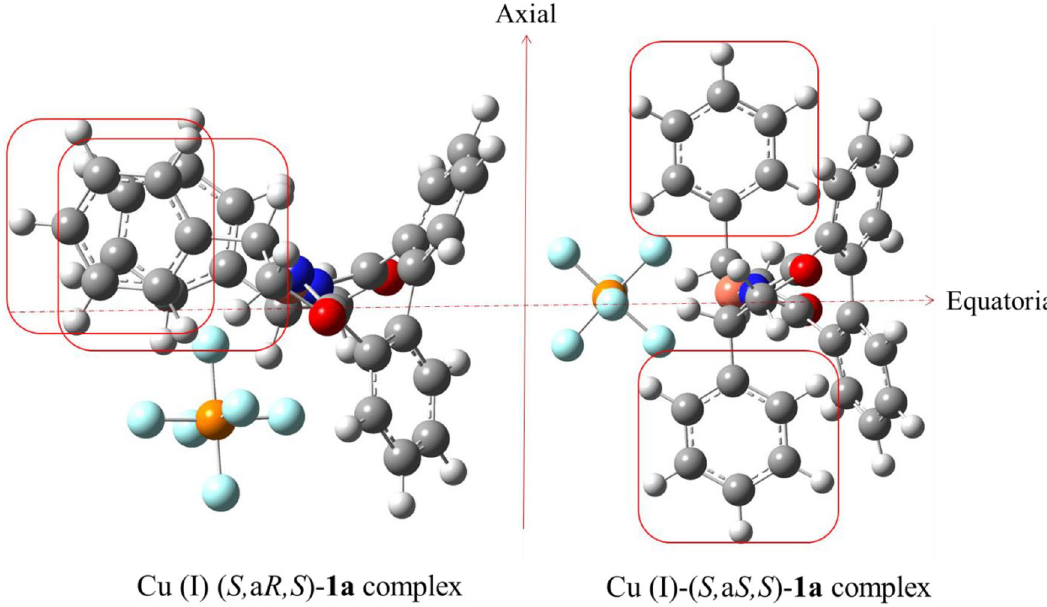
Figure 3. Optimized structures of the Cu (I) - ( S, a S,S ) and ( S, a R,S )- 1a complexes in CHCl 3 .